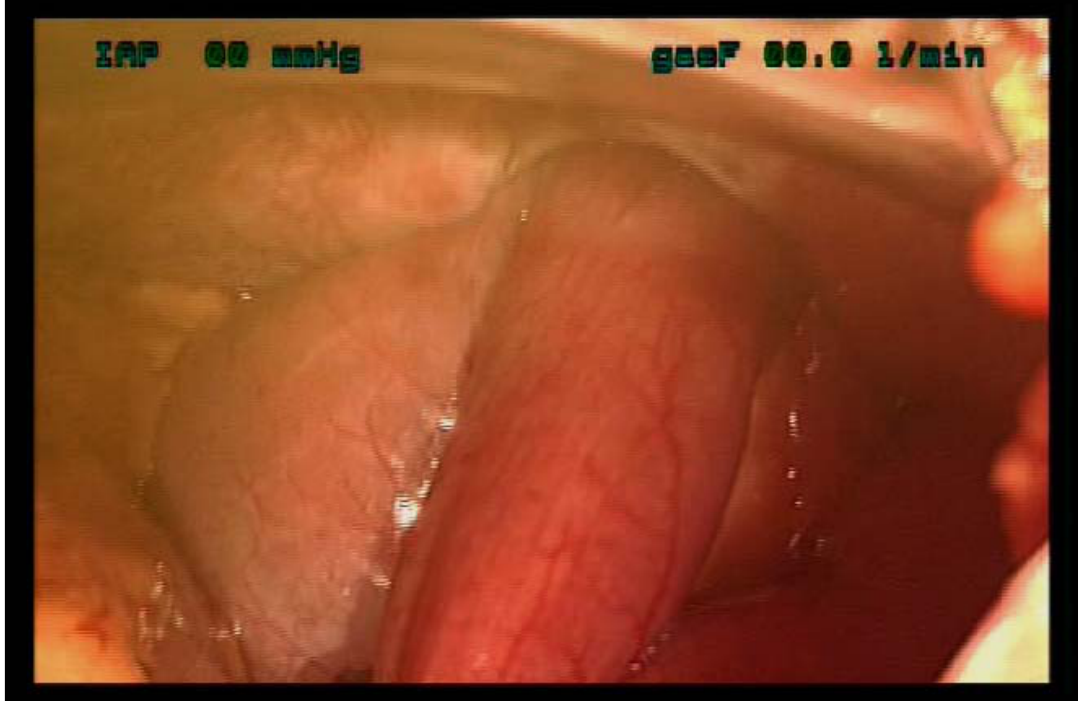
FIGURE 2. Intraoperative picture showing the loop of ileum herniated through the left lower 12-mm port site. Note the dilated proximal limb and the decompressed distal limb at the point of